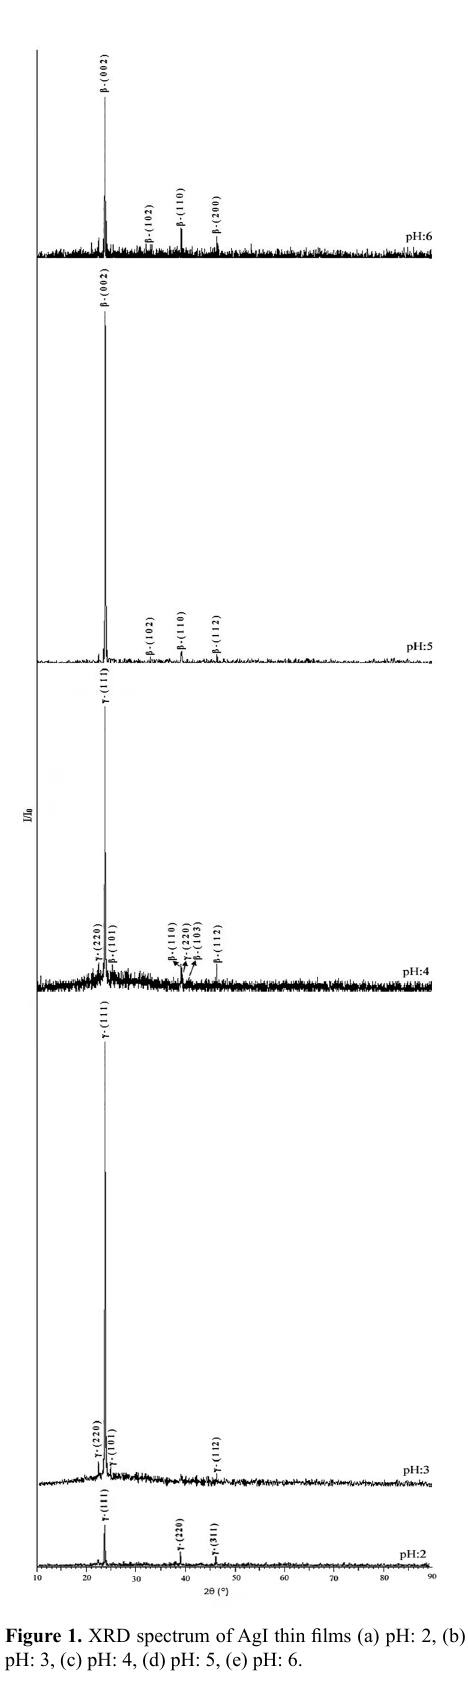
Figure 1. XRD spectrum of AgI thin films (a) pH: 2, (b) pH: 3, (c) pH: 4, (d) pH: 5, (e) pH: